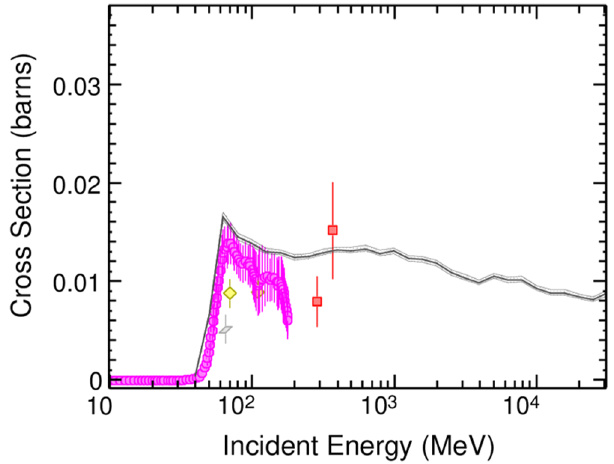
FIG. 6. nat Si ð n ; ⋆ Þ 22 Na cross section. Symbols are different experimental data sets from EXFOR [18], the gray curve results from the FLUKA interaction model. radionuclide at user defined cooling times, as a function of the input irradiation profile (specifying irradiation intervals and respective beam currents or collision rates). During the 2016 and 2017 LHC runs, the rods were irradiated for 198 and 173 days, respectively. In each simulation, the activity was computed at the end of the irradiation period.